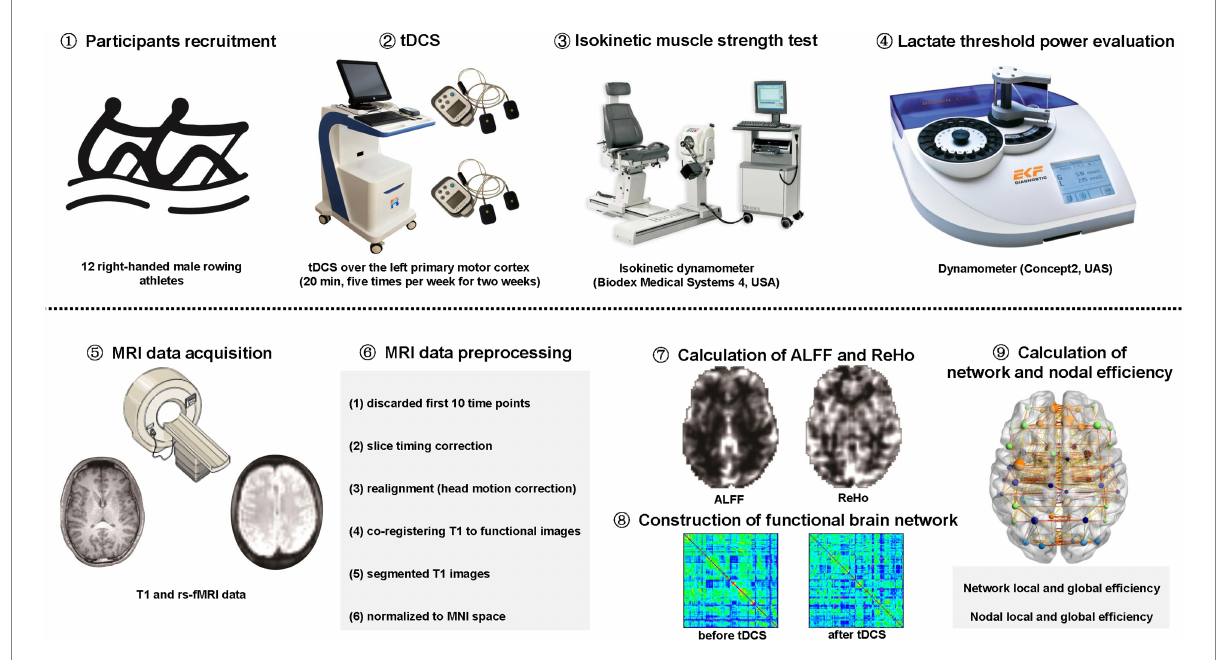
FIGURE 1 The schematic diagram for the study. tDCS: transcranial direct current stimulation. rs-fMRI: resting-state functional magnetic resonance imaging; MNI: Montreal Neurological Institute; ALFF: amplitude of low-frequency fluctuation; ReHo: regional